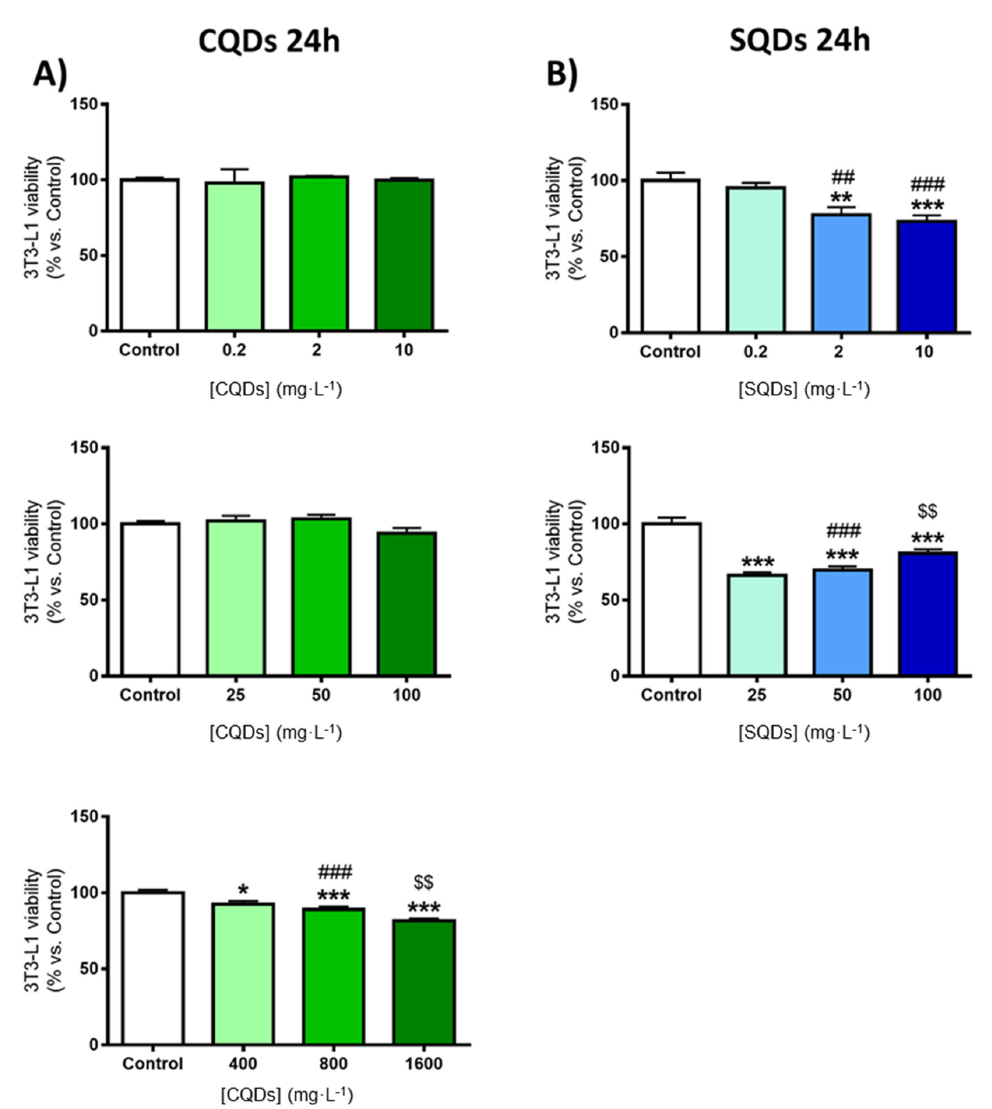
Figure 2. Cell viability data in 3T3-L1 cells cultured in the absence of serum and exposed to CQDs ( A ) and SQDs ( B ) at concentrations ranging from 0 − 1600 mg · L − 1 for 24 h. Control cells were cultured in Dulbecco’s Modified Eagle’s Medium-low glucose (DMEM) alone. Cell viability was measured by the MTT assay. Data (mean ± SEM of at least three independent experiments with three replicate wells per treatment) were analyzed by one-way ANOVA multiple comparison test followed by Fisher’s least significant di ff erence (LSD) test. Significant di ff erences are indicated as * p < 0.05, ** p < 0.01, *** p < 0.001 vs. control; ## p < 0.01, ### p < 0.001 vs. 0.2, 25, or 400 mg · L − 1 , respectively; $$ p < 0.001 vs. 50 or 800 mg · L − 1 , respectively.